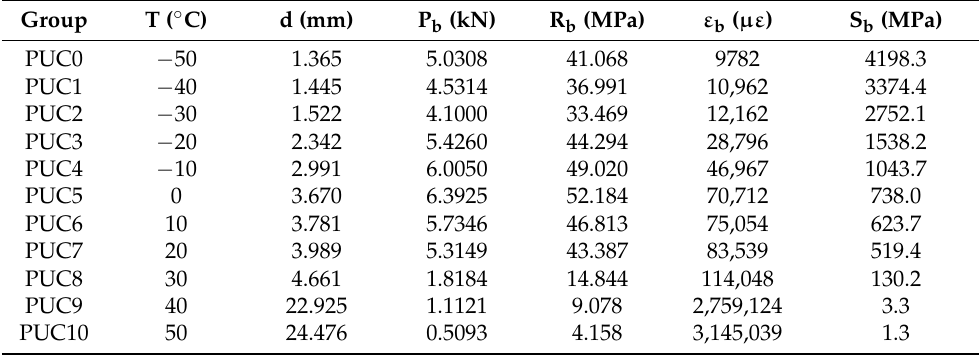
Table 8. Polyurethane cement bending test